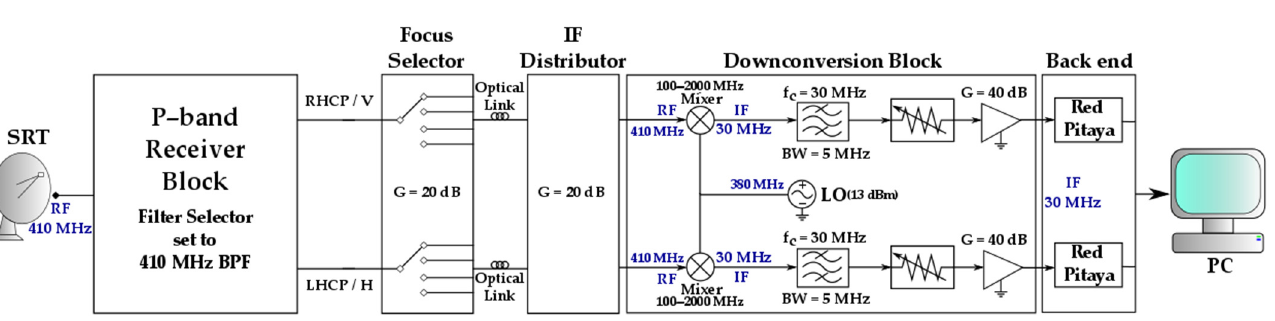
Figure 4. Radiation pattern of the SRT in P-band (410 MHz). The P-band receiver block is the first part of the space debris dedicated channel of the SRT. A complete schematic of the channel is reported in Figure 5. After the P-band receiver block, the signal goes in input to the focus selector, which allows the choice of the focus for the observation (the primary focus in our case). This section is characterized by filters, amplifiers, and attenuators, providing an overall gain of about 20 dB. From the top of the parabolic reflector, the signal is then carried down to a shielded room at ground level, by means of a 500 m optical link. Inside the shielded room, downstream to the optical link, the signal passes through the IF distributor, which allocates the signals coming from the antenna to the different back-ends, and is characterized by an overall gain of about 20 dB.